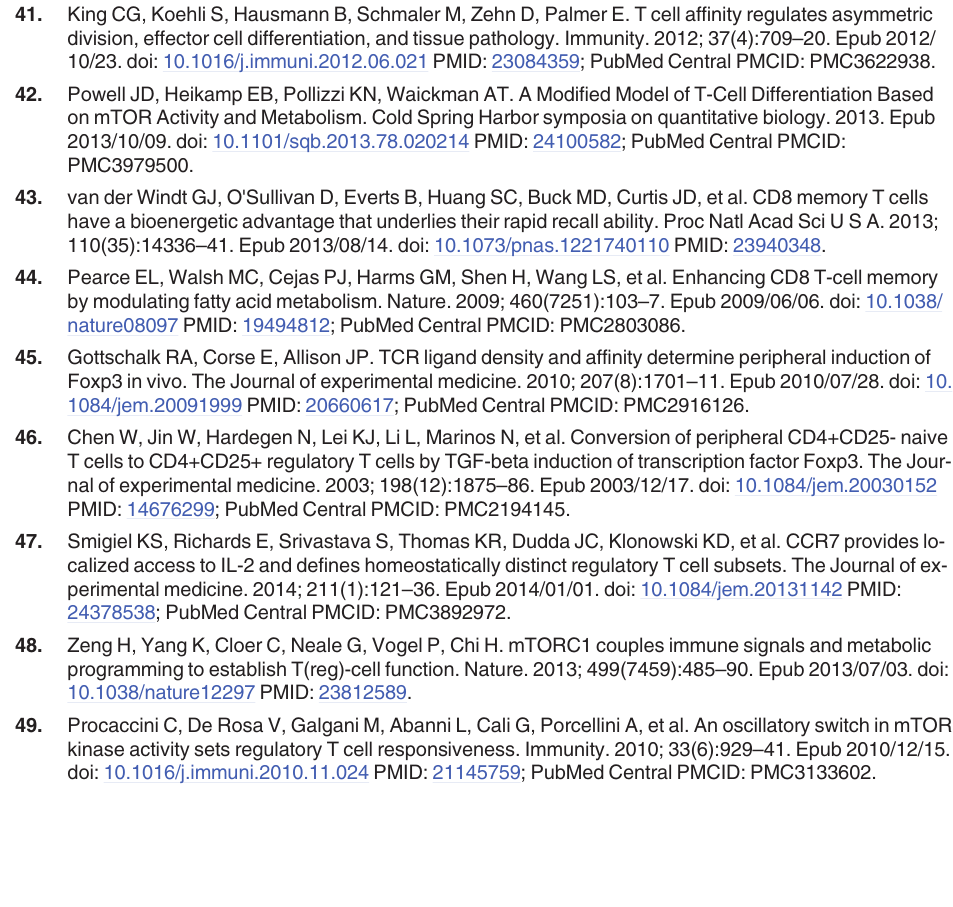
PLOS ONE | DOI:10.1371/journal.pone.0121710 April 7,